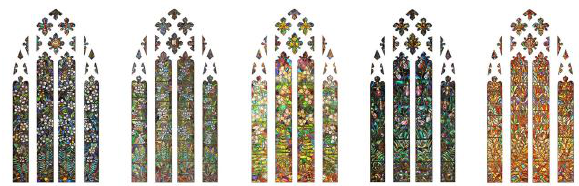
Figure 5: Stained glass images of the five provincial designs hosted by the selected frame typology.